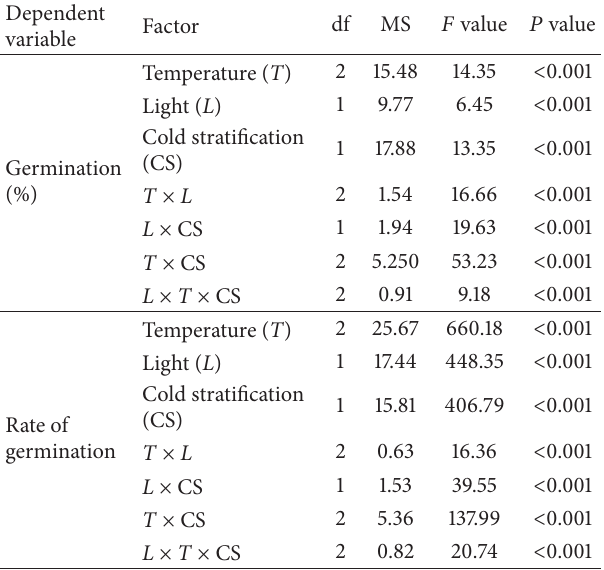
Table 1: Three-way ANOVA of effects of temperature ( 𝑇 ), light condition ( 𝐿 , light versus dark), cold stratification (CS, nontreated versus 12-week cold stratified) seeds of Rumex confertus , and their interactions on seed germination and rate of germination. Data were transformed (arcsine) to achieve normality.